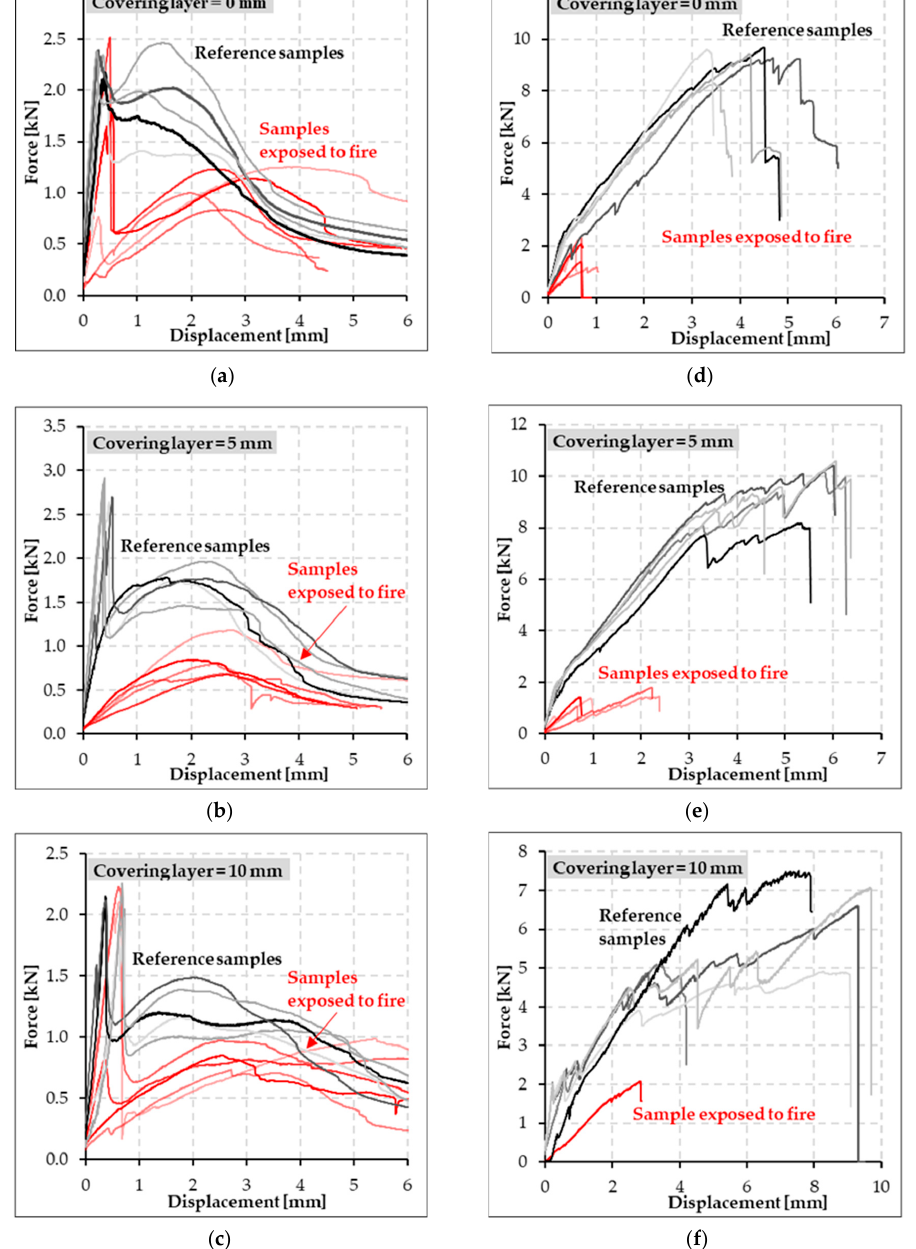
Figure 11. Comparison of the resulting residual strength of the test plate specimens after the fire test with reference specimens: ( a – c ) test plate specimens with cement suspension matrix; ( d – f ) test plate specimens with epoxy resin textile reinforcement matrix Note: All specimens mentioned in Figure 11 were made according to Table 4 from the HPC mixture No. 1.